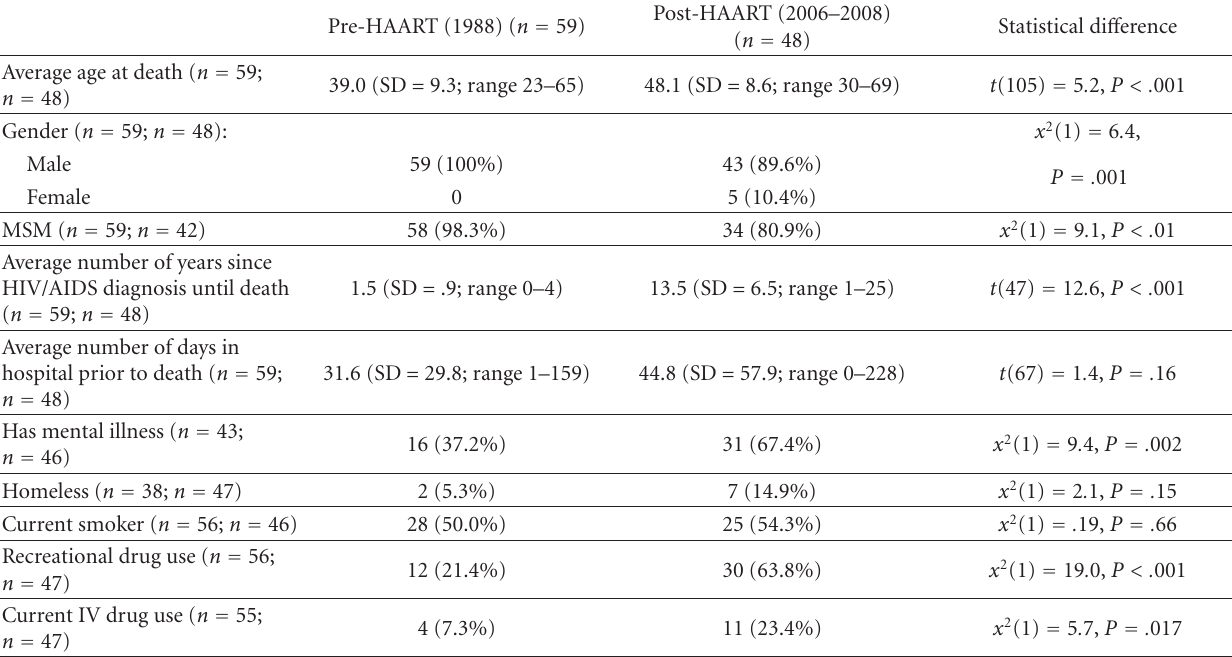
Table 1: Demographics of patients who died in the pre-HAART and post-HAART